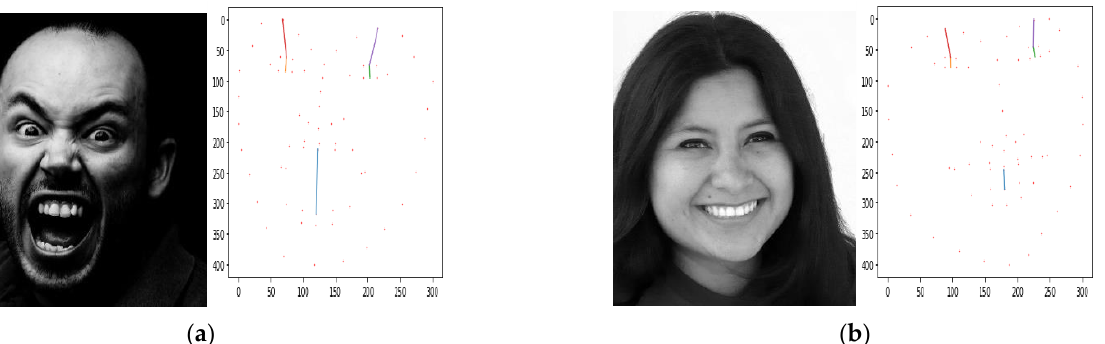
Table 1. Calculated features based on facial landmarks.